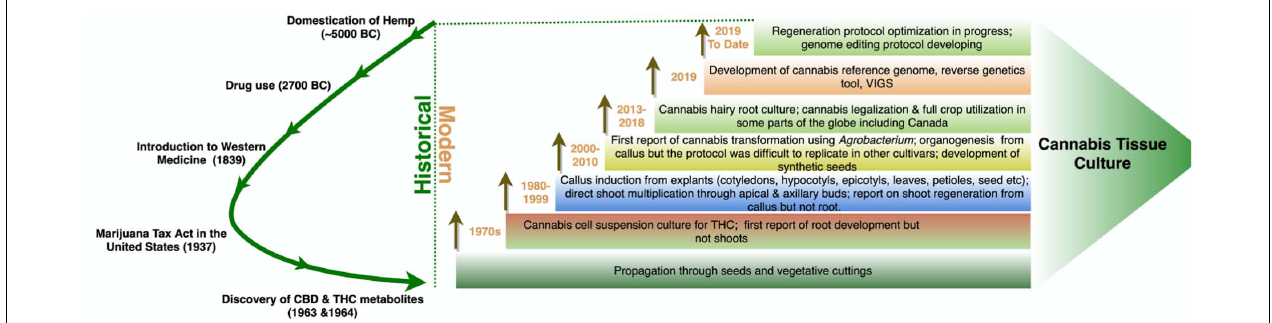
FIGURE 4 | Evolution of cannabis tissue culture research. The green curved arrow on the left shows the key events in cannabis use. Each rectangle on the right shows the major research and development activities at different years. Each brown arrow indicates that the technology is continuously developing and research work is in progress in the particular research